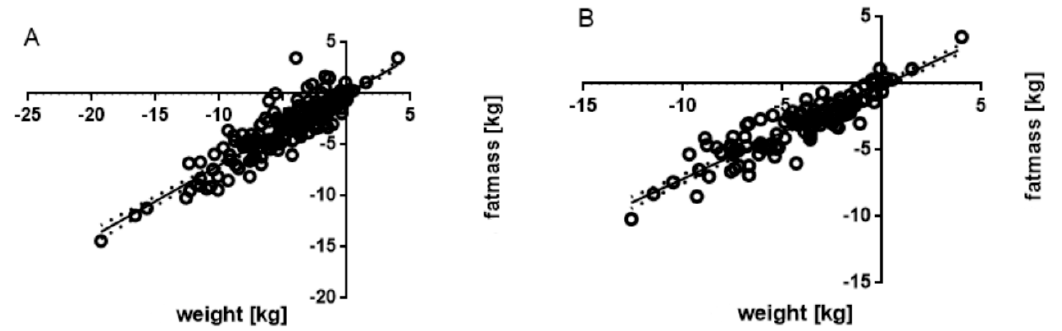
Figure 4. Association between the change in body weight and that in fat mass for all subjects ( A ) and women only ( B ). Each symbol represents one observation. The dotted area indicates the 95% confidence interval of the regression line.